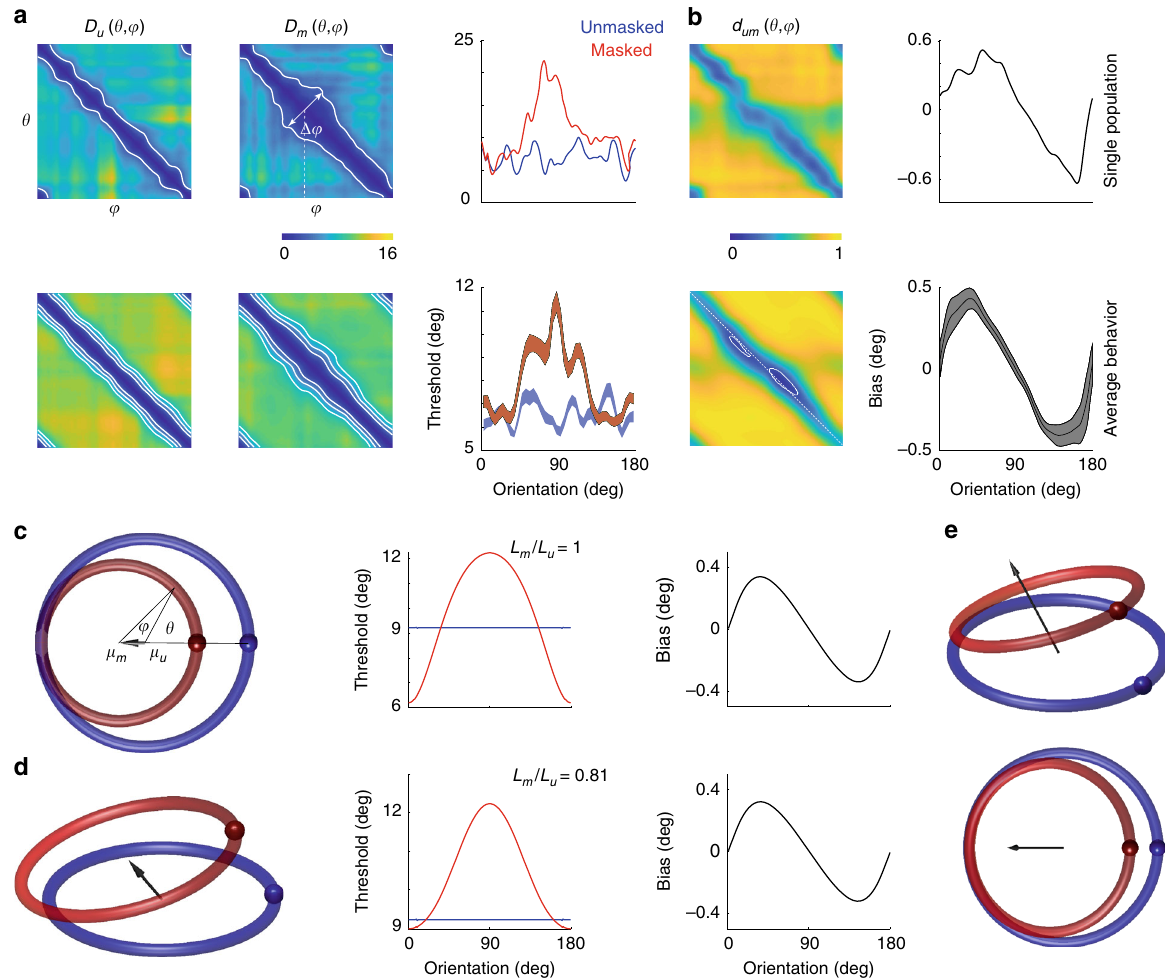
Fig. 6 A geometric model of masking. a Discriminability (d-prime) between the representation of two orientations in unmasked (left panels) and masked (middle panels) conditions. The top panels show results for one experiment, while the ones at the bottom show the average across all our experiments. Iso- performance contour for the single experiment is shown at d 0 ¼ 4. The iso-performance contours for the average behavior is shown at levels of d 0 ¼ 4 ; 6 ; 8. The widening in the iso-performance contours in the masked condition re fl ect an increase in thresholds near the mask (which has an orientation of 90°). This is best shown in the panels on the right, which show the dependence of thresholds in masked (red) and unmasked (blue) conditions as a function of a base angle. In the average data the shaded areas represent ± 2 SEM. b Mutual distances and bias. Top panels show the mutual distance between orientations across masked and unmasked representations ( d um ) and the expected bias from a decoder based on the distances. The non-diagonal structure of d um is more evident in the average data (bottom left panel), showing the locations of the minima of the main diagonal (white, dashed line). Bottom right panel shows the average bias across all our experiments. Shaded areas represent 2 SEM. c Two-dimensional geometric model of population coding 66 . The model assumes r u θ ð Þ and r m θ ð Þ are two circles in the plane. The displacement of their centers (white points) induce changes in the mutual distances inducing corresponding changes in threshold (middle panel) and bias (right panel). d The model can be extended by allowing displacement of the curves along a third dimension. e Two viewpoints of the same population activity in ( d ) but now normalized to yield ^ r u θ ð Þ and ^ r m θ ð